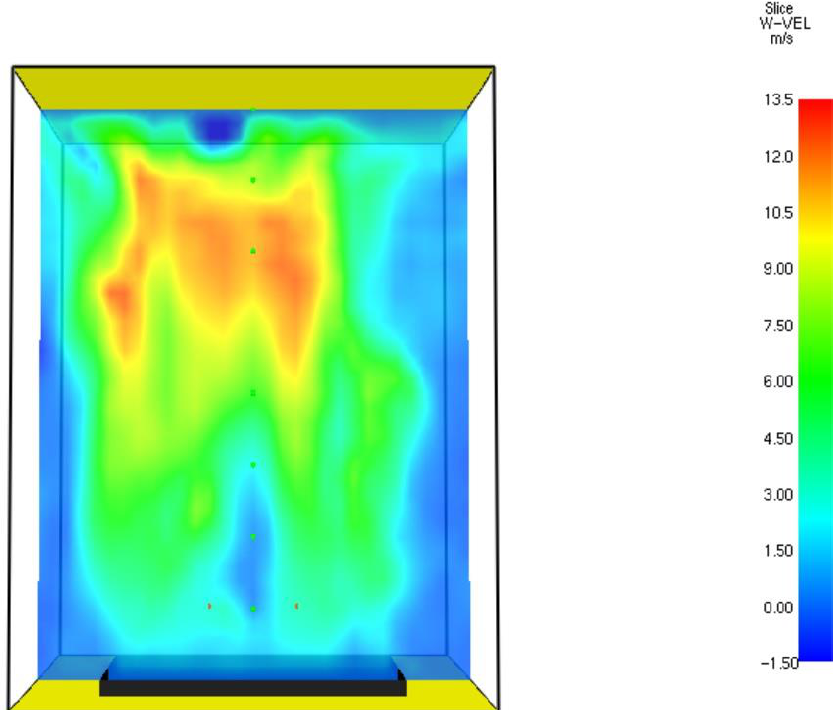
Figure 5. Velocity field (m/s) of the flue gaseous mixture at t = 60.7 s. From Figure 5 it can be seen that the gaseous mixture flows upwards because of buoyancy forces. The velocity is higher near the ceiling. Based on the thermocouples and CO 2 sensor readings, the following plots were constructed. Figure 6 shows the Heat Re- lease Rate (HRR). Figure 6. Heat Release Rate (HRR) of the pet-coke particles.